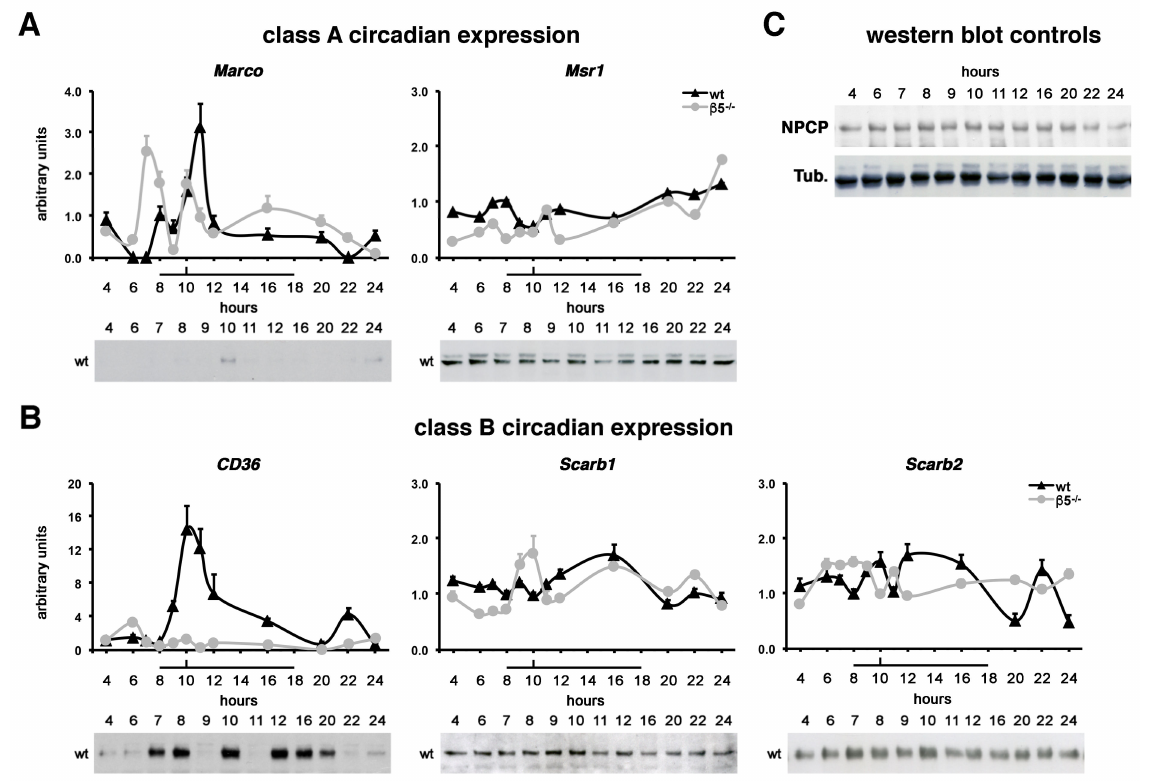
Figure 5. Class A MARCO and class B CD36 show rhythmic expression patterns in vivo. qPCR quantification of RPE/choroid gene expression and associated western blots of protein expression profiles ( A , B ) at different times along the light:dark cycle (horizontal bar indicates light) show that Marco ( A ) and CD36 ( B ) displayed a peak of gene expression at 11.00 and 10.00–11.00 at or just after the phagocytic peak (black wedge) in wild-type controls (wt, black line and triangles) when compared to arrhythmic RPE/choroid from integrin β 5 knockout mice ( β 5 − / − , grey line and dots) as indicated. Scarb1 (SR-BI) gene expression displayed a slight peak at 9.00–10.00 in β 5 − / − samples ( B ), and Scarb2 (SR-B2/LIMP-2) decreased at 20.00 and 24.00 in wt controls, but not in β 5 − / − RPE/choroid. Msr1 (SR-BI) did not indicate any variation in gene expression. Results are displayed as 2 ∆∆ Ct averages ± standard deviation in arbitrary units (a.u.), reference is wt at 8.00 (light onset), n = 3–6. Protein expression levels were augmented at 10.00 for MARCO ( A ) and at 7.00–8.00, 10.00 and 12.00–20.00 for CD36 ( B ) in wild-type samples (wt), while SR-AI ( A ), SR-BI and SR-B2/LIMP-2 ( B ) did not show any significant changes. Western blots for the nuclear pore complex protein (NPCP) and tubulin (Tub.) control proteins show no variation along the different hours of the light:dark cycle studied in wild-type mice, as indicated ( C